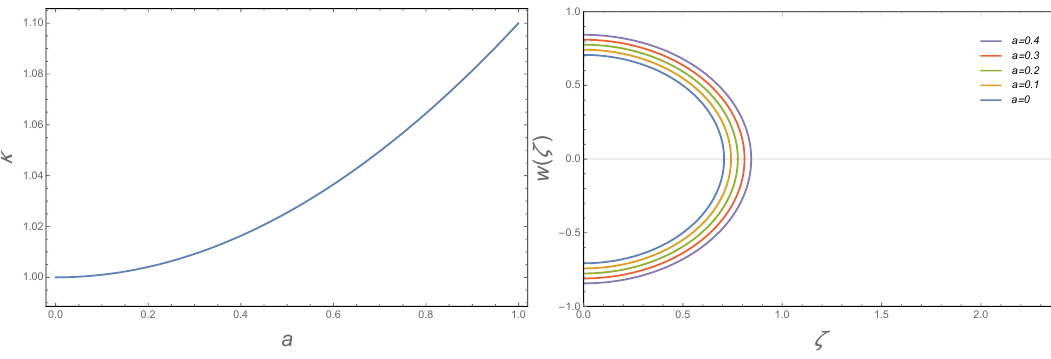
Figure 10 . Left: the relation of κ and a . Right: the embedding of the Chern-Simons brane on { w, ζ }